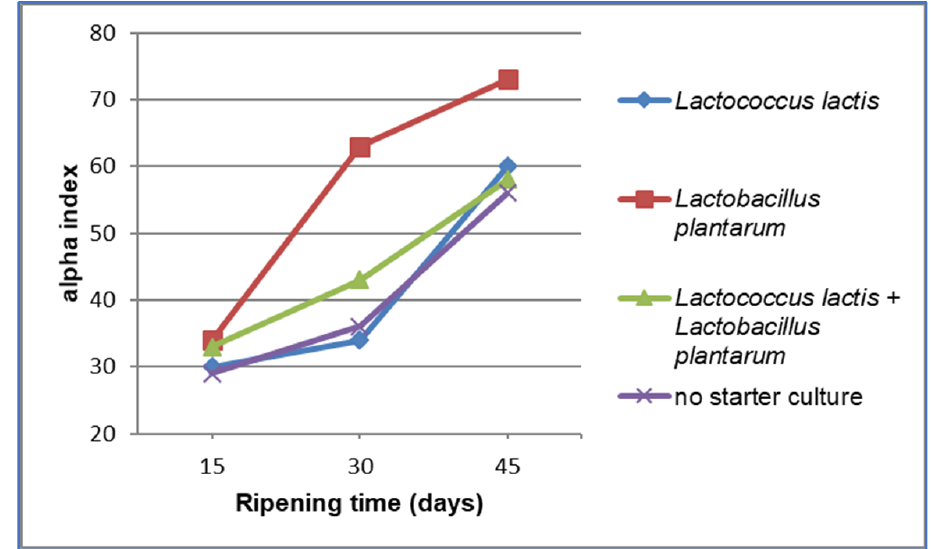
Figure 3. Alpha index of Sir iz mišine at 15, 30, and 45 days of ripening.